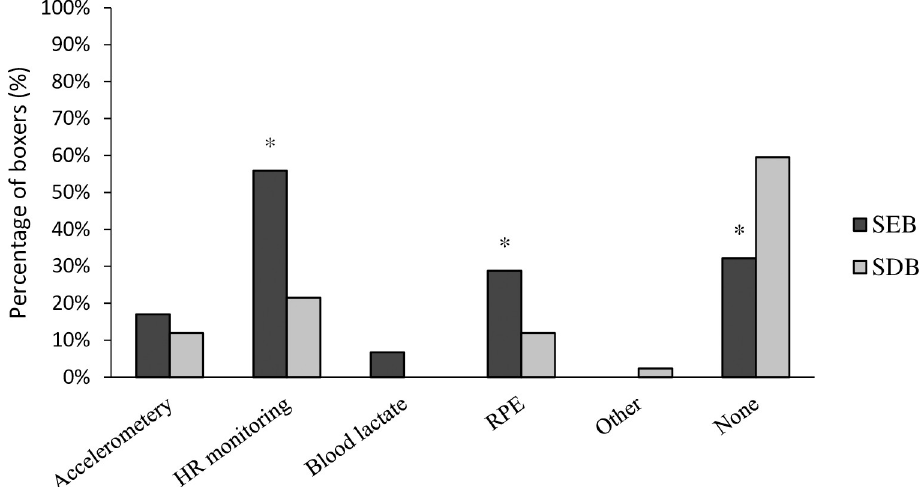
Fig 2. Percentage of boxers who monitored training intensity. � denotes significant association between competitor level and method of monitoring training intensity (P � 0.005).